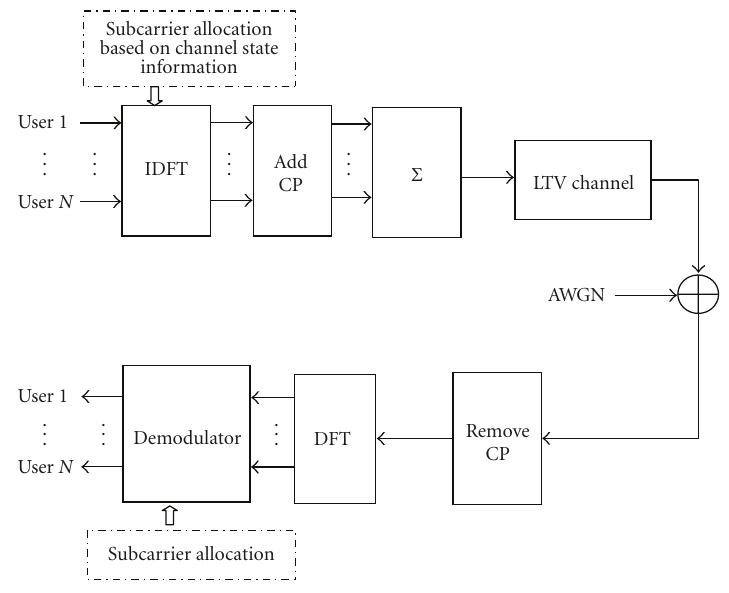
Figure 1: System